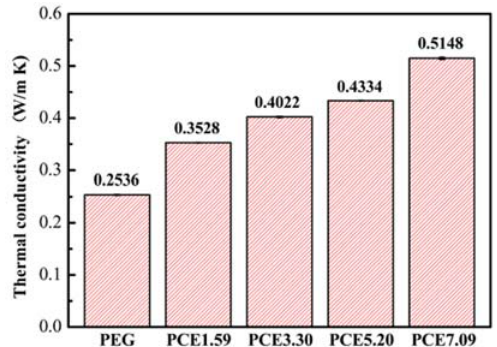
Figure 7. Thermal conductivity of PEG and PCE-CPCMs.